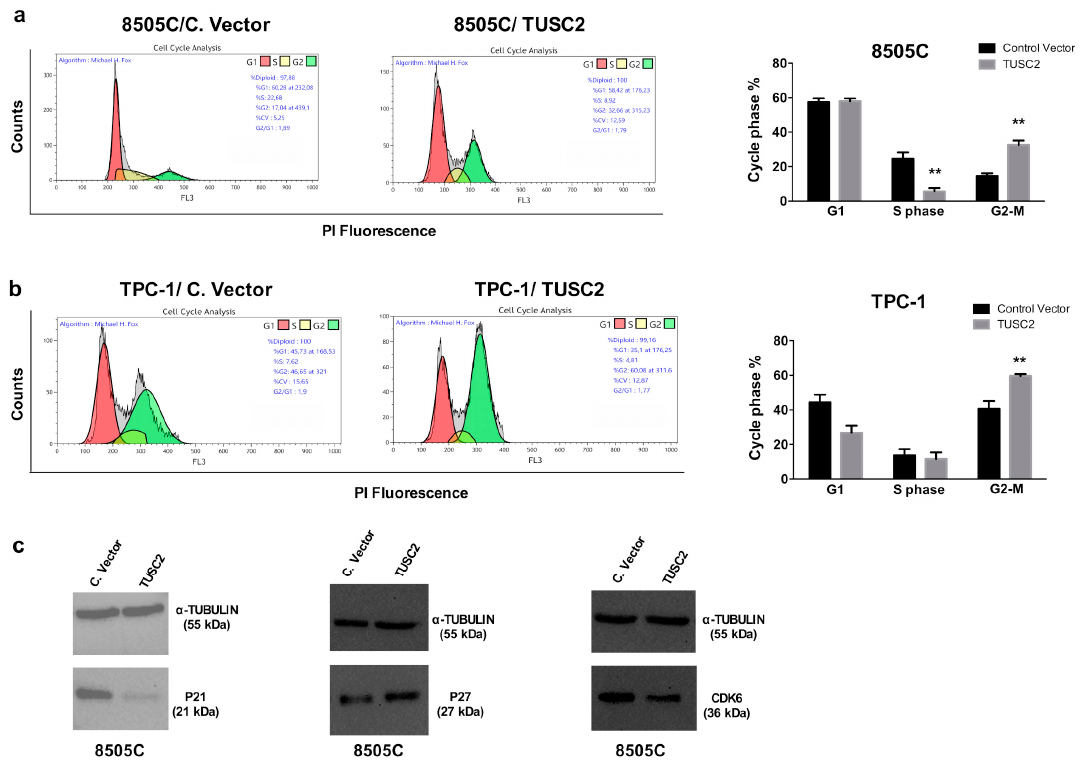
Figure 2. TUSC2 forced expression reduced thyroid cancer cell proliferation. Flow cytometry analysis of the cell cycle distribution in 8505C ( a ) and TPC-1 ( b ) cells stably transfected with TUSC2 or with Control Vector (C. Vector) plasmids. A representative fluorescence-activated cell sorting (FACS) plot is shown in the left panel while the average of two independent experiments is shown on the right. ** p < 0.01. Error bars indicate standard errors. ( c ) Western blot of p21, p27, CDK6 and TUBULIN in 8505C / C. vector and 8505C / TUSC2 cells.